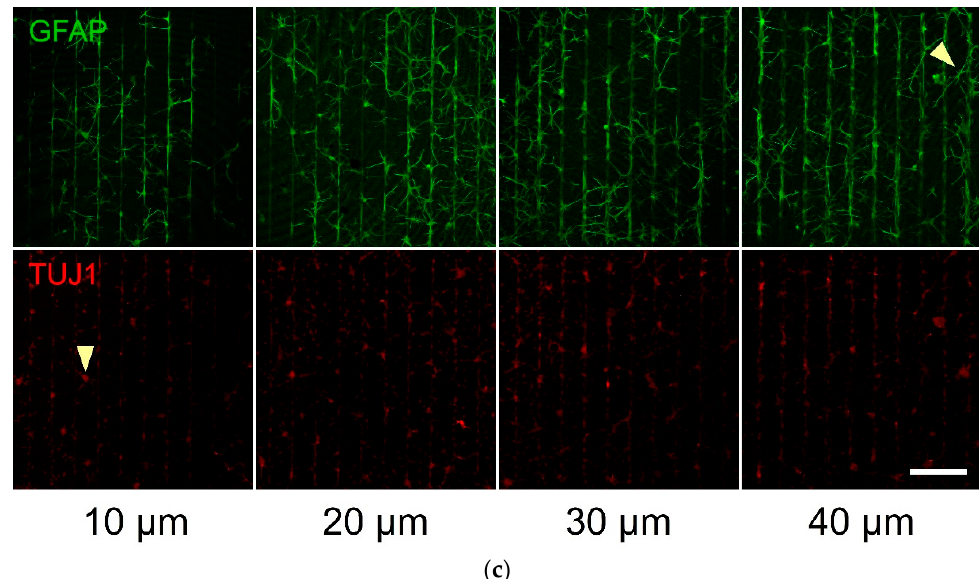
Figure 4. Patterned primary culture examples of hippocampal neurons and astrocytes on parylene-C stripes of different geometries (width of parylene-C stripes below each column). The GFAP antibody (green channel) stained the astrocytes, whereas the TUJ1 antibody only stained the neuronal cells (red channel): ( a ) 7 DIV culture, ( b ) 14 DIV culture and ( c ) 21 DIV culture. White arrowheads point to cells localised on the parylene-C stripes, while yellow arrowheads point to processes bridging neighbouring stripes. Scale bar is 500 μ m.